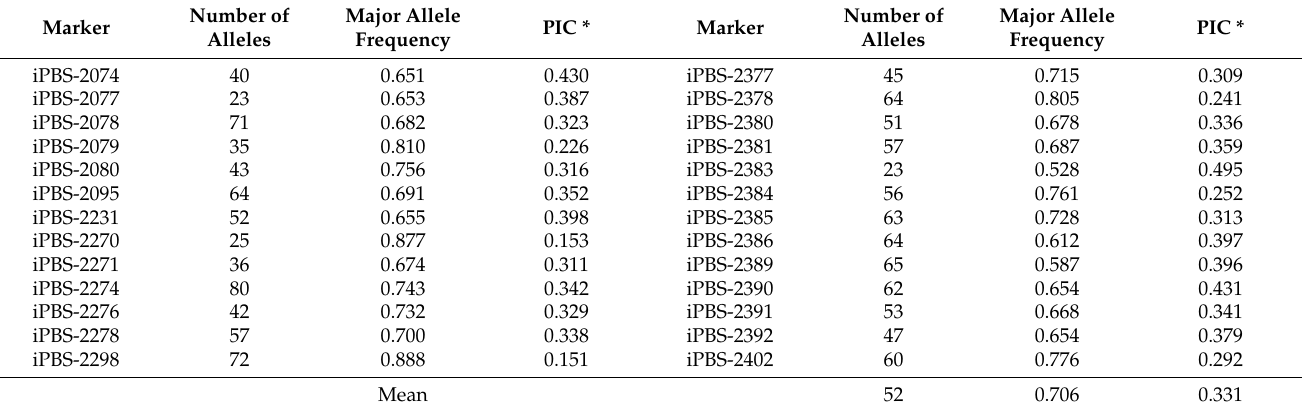
Table 3. Twenty-six iPBS primers used in the detection of polymorphism among 40 local varieties and 5 commercial cultivars of beans ( P. vulgaris L.).